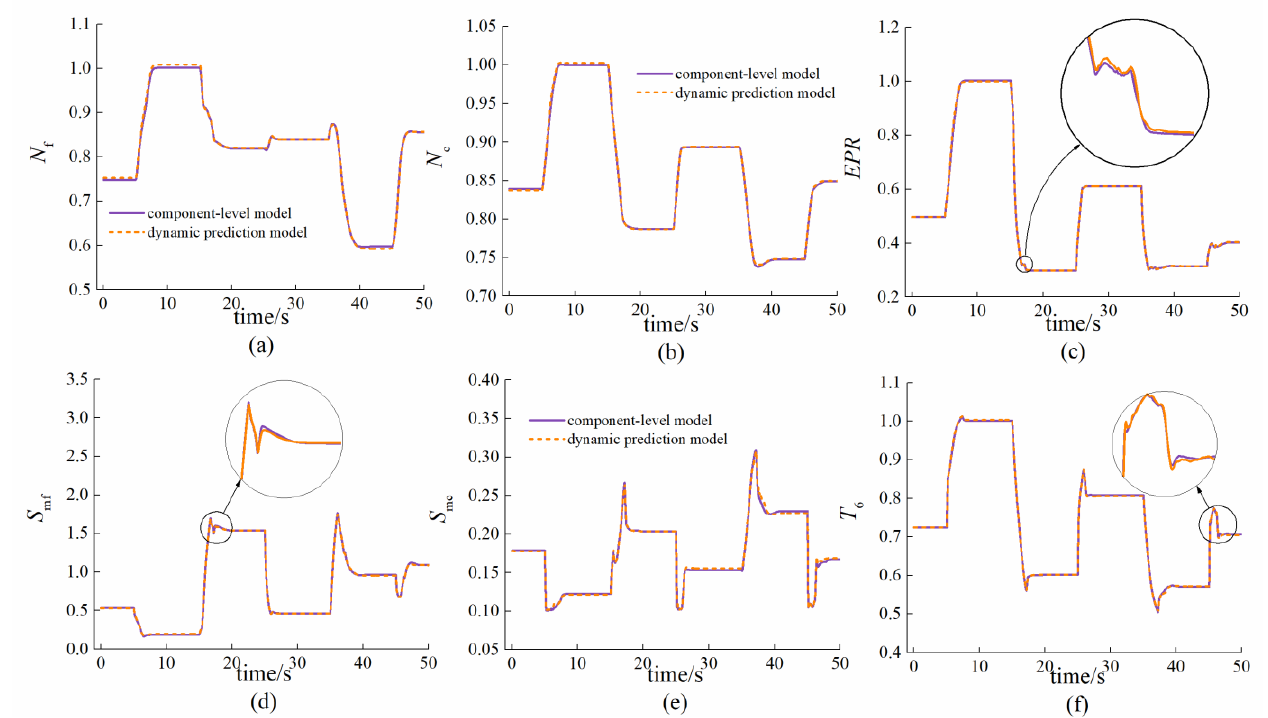
Figure 10. The comparison between the multi-step predictive control curve of the dynamic predictive model and the control curve of the component-level model: ( a ) simulation curve of the physical fan rotor speed; ( b ) simulation curve of the physical compressor rotor speed; ( c ) simulation curve of the engine pressure ratio; ( d ) simulation curve of the fan surge margin; ( e ) simulation curve of the compressor surge margin; ( f ) simulation curve of the high-pressure turbine outlet temperature.